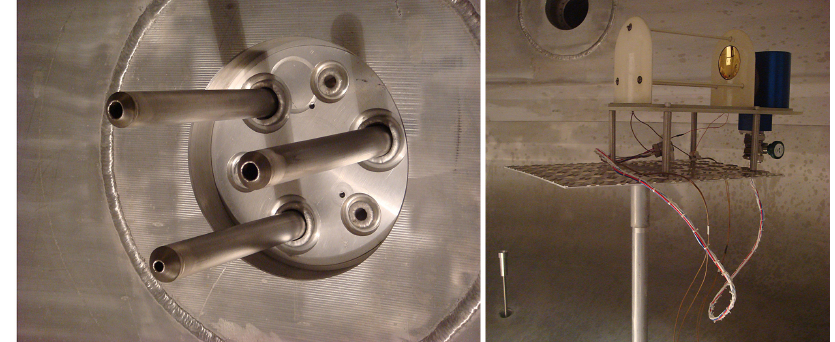
Figure 3. Left: customized extractive sampling probes inside the chamber. This cluster of three probes was located on the lower right-hand chamber wall (lower right hand in Fig. 2) and provided chamber airflow to several instruments. These probes are either 10 or 16mm inside- diameter stainless-steel tubes surrounded by a sealed heating mantle and extending 35 cm into the chamber. Right: the JPL TDL open-path instrument mounted inside the chamber. The instrument electronic module remained outside the chamber.